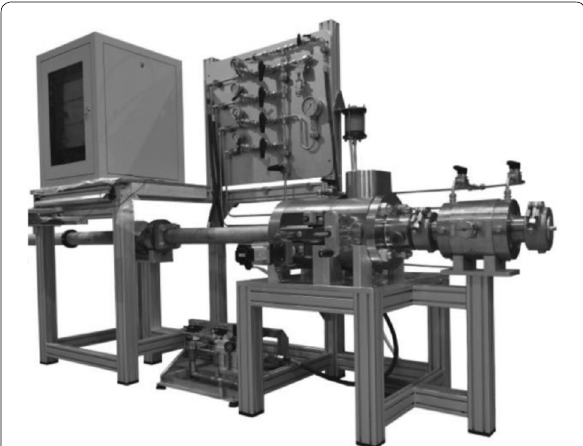
Figure 16 Mini-pressure-retaining core analysis and transfer system